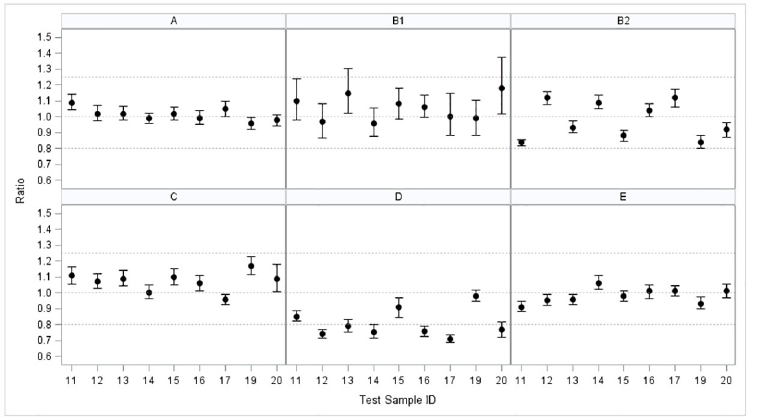
Fig 1. Graph of ratio of laboratory mean concentration to consensus value with 90% confidence intervals for each test sample by laboratory. Dotted lines show equivalence region (0.80 to 1.25) and perfect agreement with consensus value (1.00). All means and confidence bounds are entirely within equivalence region for Laboratories A, B2, C, and E.